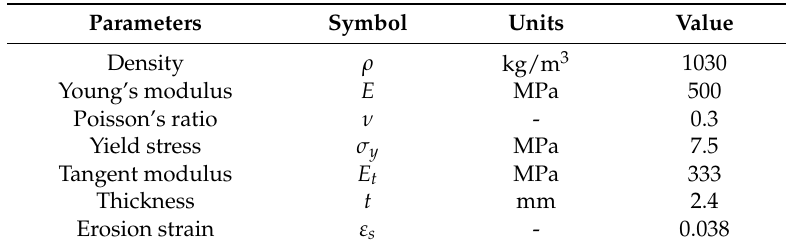
Table 4. Parameters for Geogrid MG-100 using the plastic-kinematic